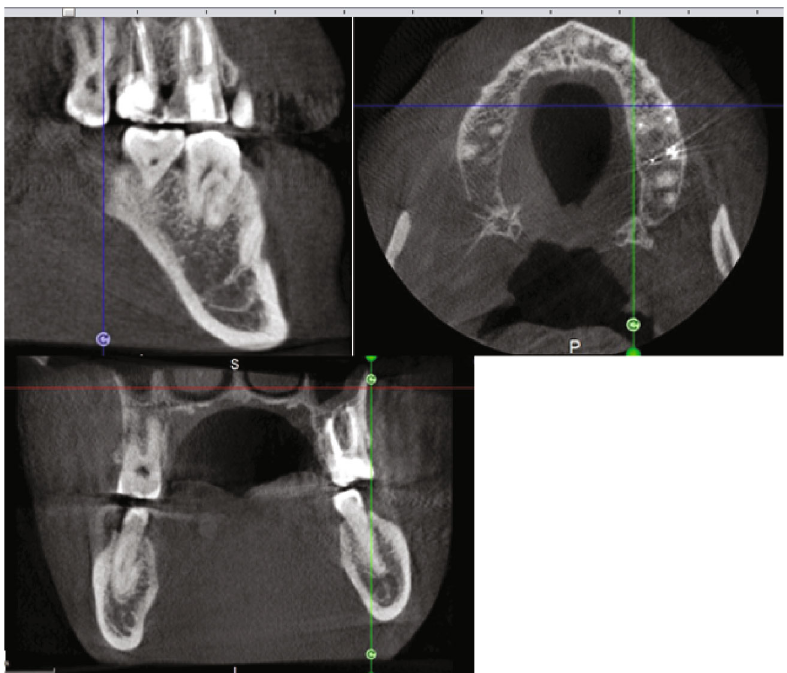
Figure 11: CBCT after 10 months of